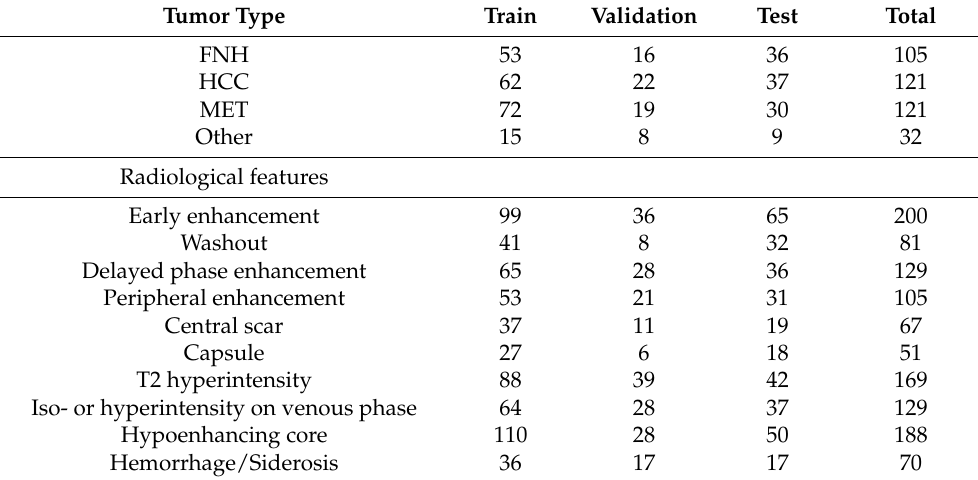
Table 2. Distribution of lesions and annotated features among